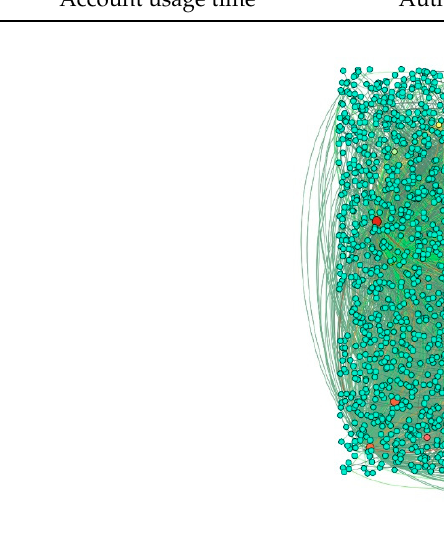
Figure 1. Dataset Figure 1. Dataset 1.